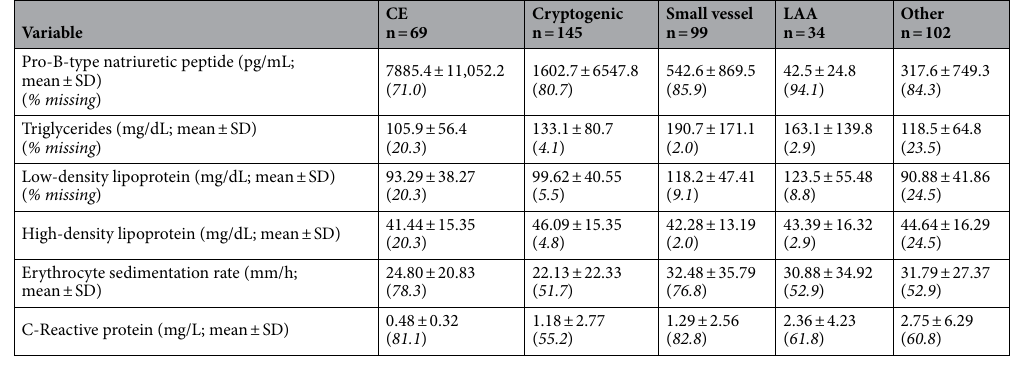
Table 1. Population characteristics and biomarker and risk factor profiles for stroke subtypes (n = 449